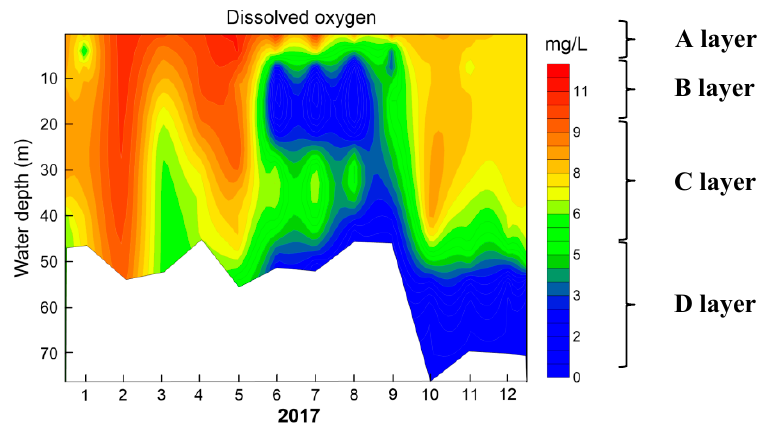
Figure 3. Seasonal DO depth profile of S1 site in Lijiahe Reservoir in 2017. Table 1. Anoxia thickness in B layer and proportion in site S1 in Lijiahe Reservoir from June to September in